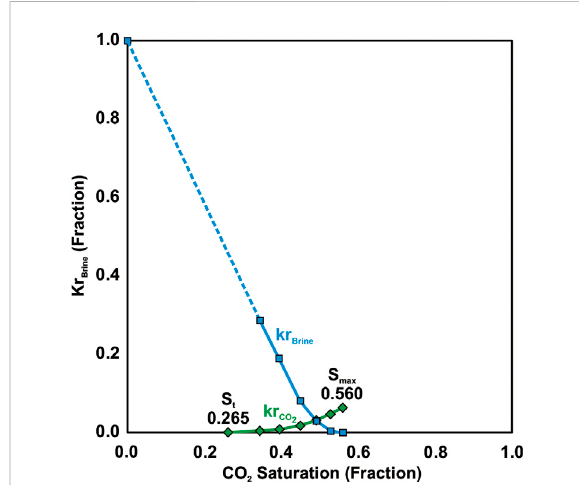
FIGURE 11 CO 2 – brine relative permeability tests of the Rose Run in the 1 Hanson Aggregates. Relative permeability to brine (kr Brine ) is shown in blue and to CO 2 (kr CO2 ) in green. Maximum CO 2 saturation (S max ) and residual CO 2 saturation (S t ) points are posted. Capillary trapping ef fi ciency, the percentage of residually trapped CO 2 in the Rose Run ( R % = (S t /S max ) × 100; Burnside and Naylor, 2014), is 47.3%. That is, almost half of the CO 2 injected into the Rose Run would be trapped in the pore space and unable to migrate out of the reservoir in the event of a seal